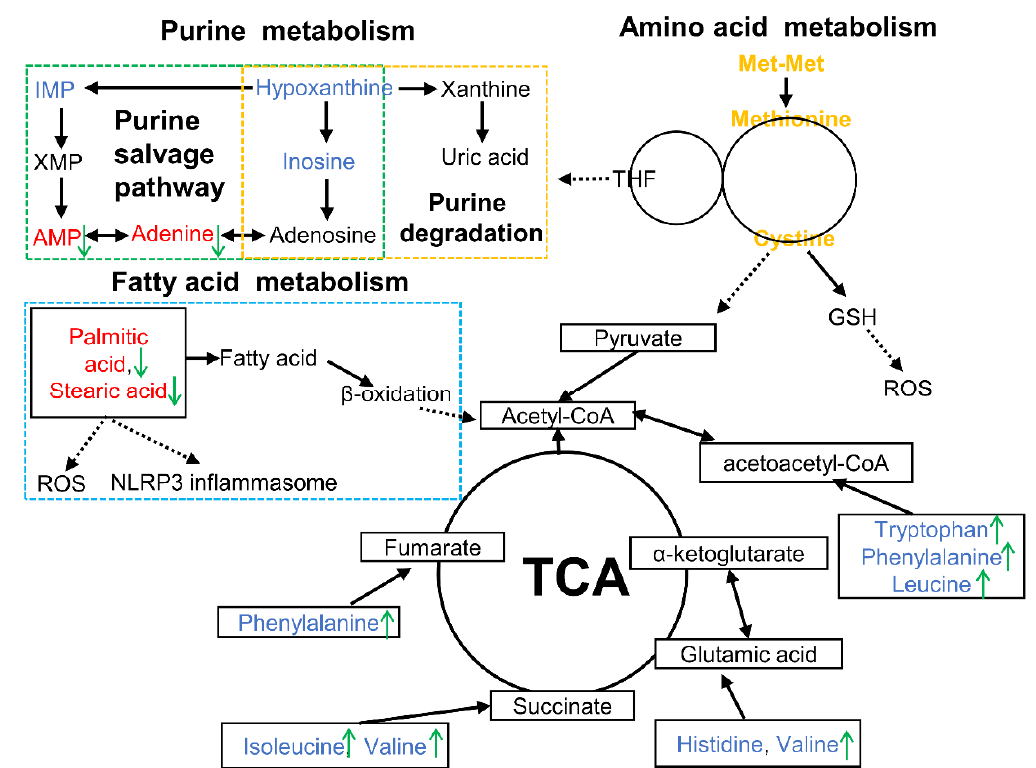
Figure 6. Overview of metabolic alterations related to Met-Met alleviating bovine mammary epithelial cell inflammation. Note: The red font represents increased DMs, while the blue font means the decreased DMs in the LPS vs. CON comparison. The green arrows indicate the changed DMs in the Met-Met+LPS vs. LPS group. AMP, adenosine monophosphate; DMs: differential metabolites; GSH, glutathione; IMP, inosine 5 ′ -monophosphate; ROS, reactive oxygen species; TCA, tri- carboxylic acid cycle; THF, tetrahydrofolate; XMP, xanthosine monophosphate.